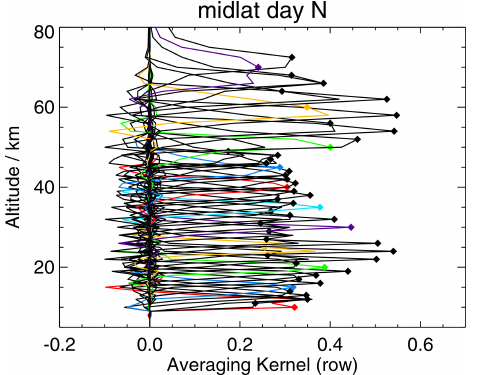
Figure 4. MIPAS temperature averaging kernels for a northern mid- latitude daytime observation. For clarity, the kernels belonging to retrieval altitudes 10, 15, 20 ... km are color-coded. Diamonds rep- resent the nominal